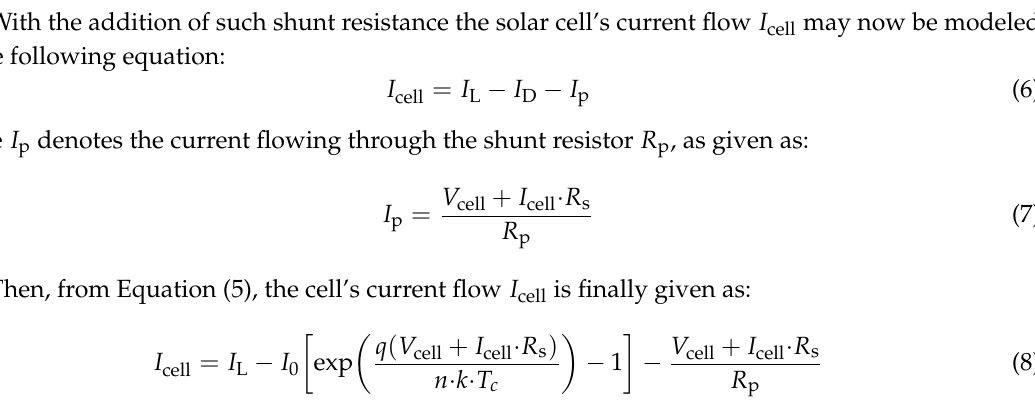
Figure 3. Single-diode model of a photovoltaic cell, which includes both a lumped series resistor R s and a shunt resistor R p .